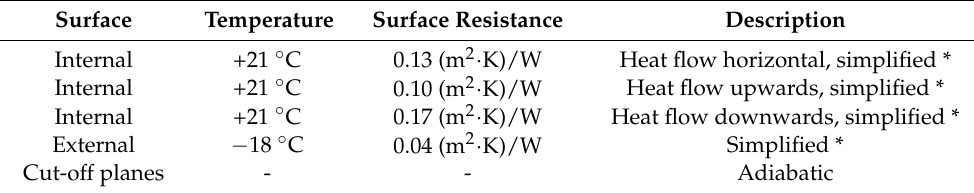
Table 3. Boundary conditions adopted in modelling.